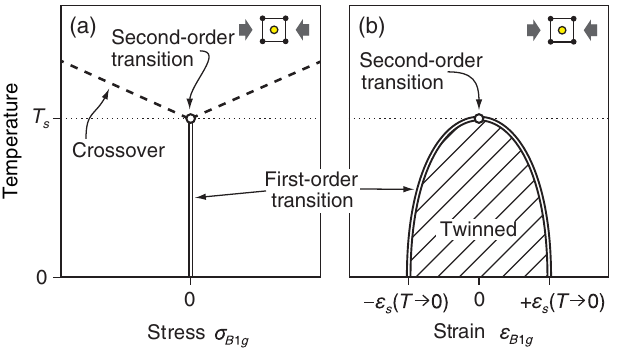
FIG. 3. Schematic phase diagrams. (a) Schematic stress-tem- perature phase diagram for the nematicity of FeSe, for stress applied with B 1 principal axes; the first-order transition is where g the direction of the nematicity flips. (b) The corresponding strain- temperature phase diagram. In the indicated region, the lattice is unstable and breaks up into twins where, locally, ε